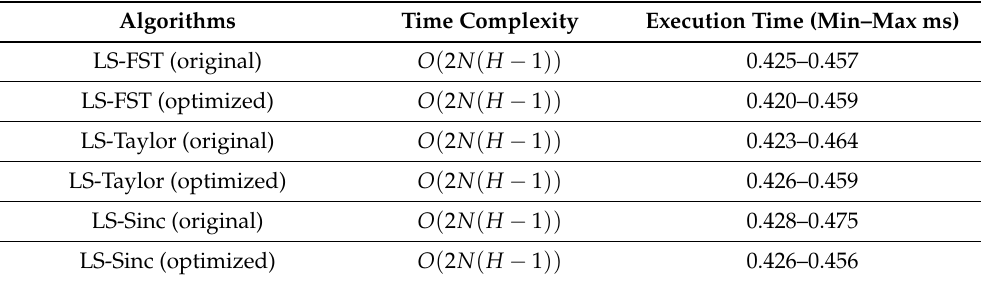
Table 4. The computation analysis of the LS-FST, LS-Taylor, and LS-Sinc with and without the proposed